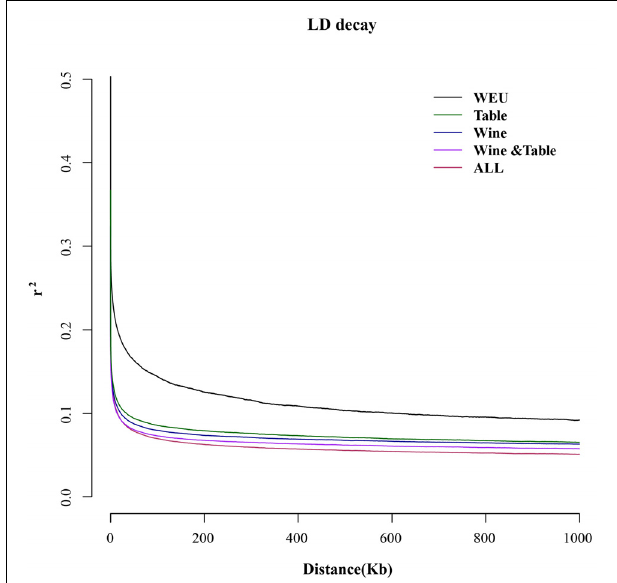
FIGURE 3 | Decay of linkage disequilibrium in different sub-groups and different chromosome regions.